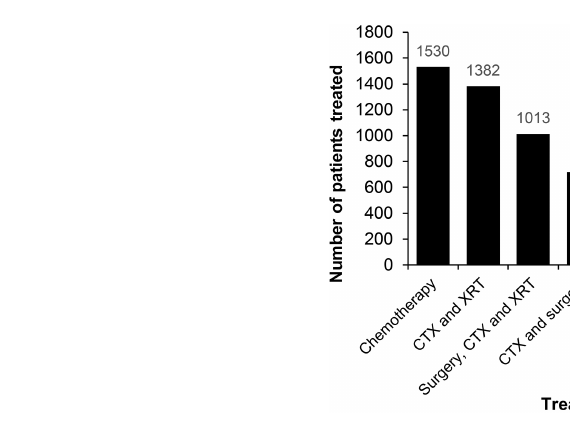
FIGURE 3 Treatment outcomes for adult male and female